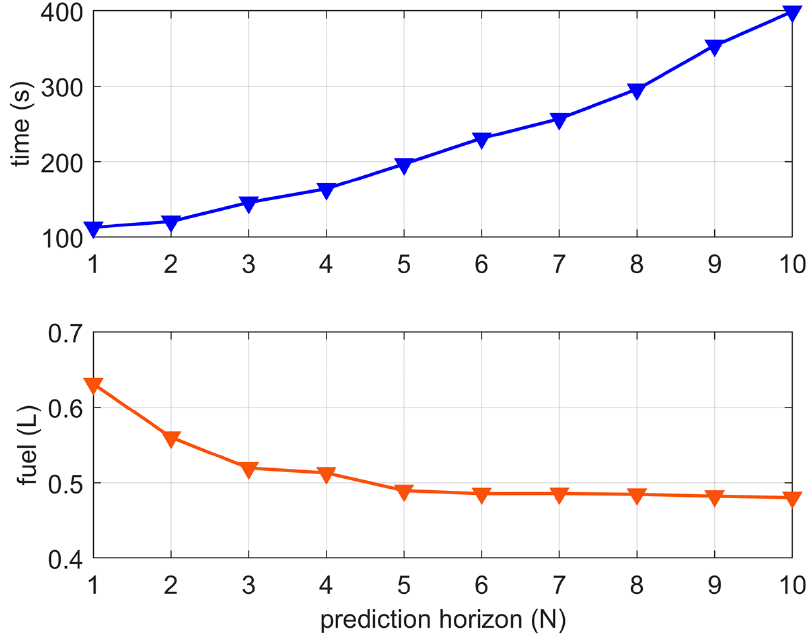
Figure 13. The computation time and the fuel consumption with di ff erent prediction horizon.